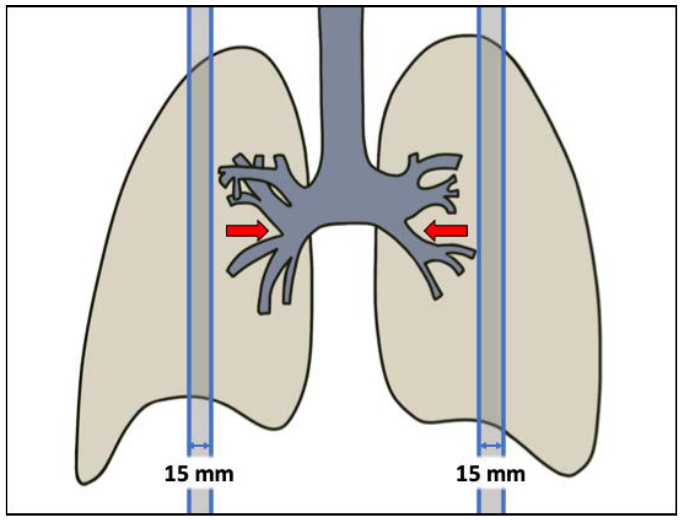
Figure 1. Demonstration of the approximate location of the 15 mm sagittal slice, shown as the shaded region, chosen for analysis of the lung lateral to the hilar vessels. Red arrows illustrate the hilar points of the right and left lungs.